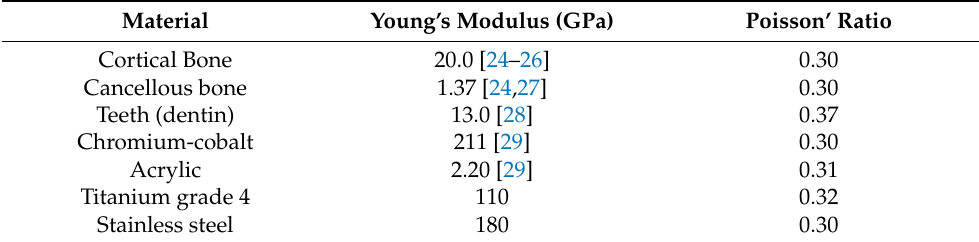
Table 3. Mechanical properties of the isotropic linear elastic